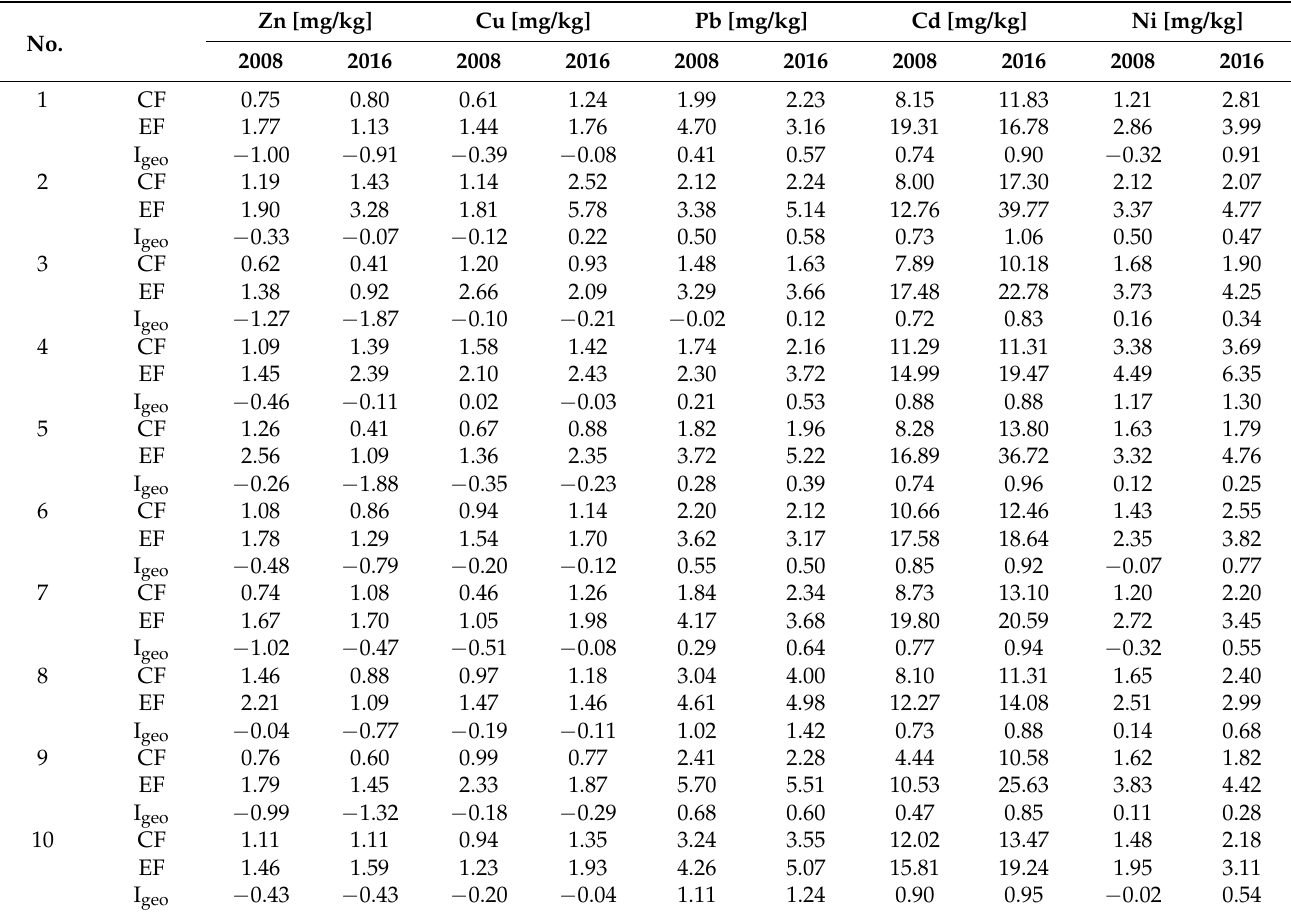
Table 3. Geoaccumulation index (I geo ), contamination factor (CF), enrichment factor (EF) of total metal contents in